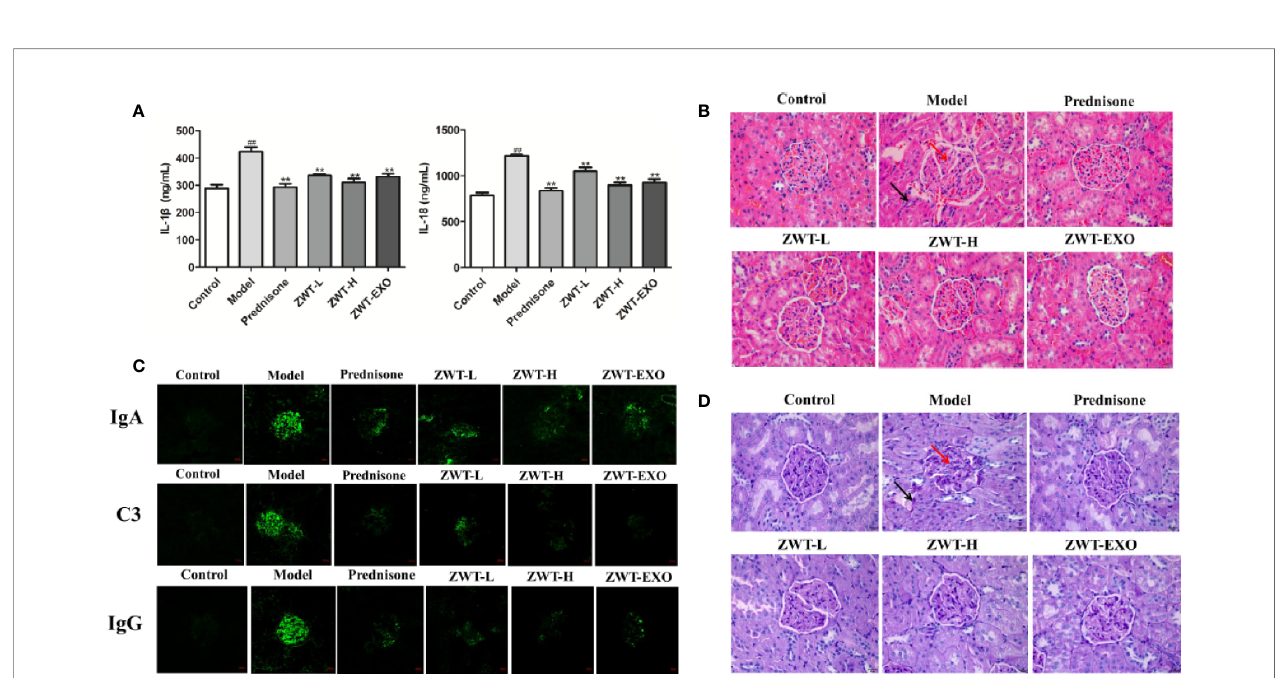
FIGURE 7 | Exosomes dampened renal in fl ammation and structure damage of immunoglobulin A nephropathy (IgAN) rats. (A) IL-1 b and IL-18 levels in the IgAN renal tissues from the different groups. (n= 5). (B) The photographs of H&E staining in IgAN renal tissues under a light microscope at 400× magni fi cation. Scale bar: 20 m m. The arrows indicated the partial pathological changes as in fl ammatory in fi ltration with black arrow and glomerulus swelling with red arrow. (C) Circulating immune complexes of IgA, IgG, and C3 in the renal tissues were examined by confocal imaging at ×200 magni fi cation. Scale bar: 20 m m. (D) The images of IgAN renal tissues by Periodic Acid-Schiff (PAS) staining under a light microscope at ×400 magni fi cation. Scale bar: 20 m m. Black arrow: mesangial cells proliferation and cellular in fi ltration. Red arrow: matrix